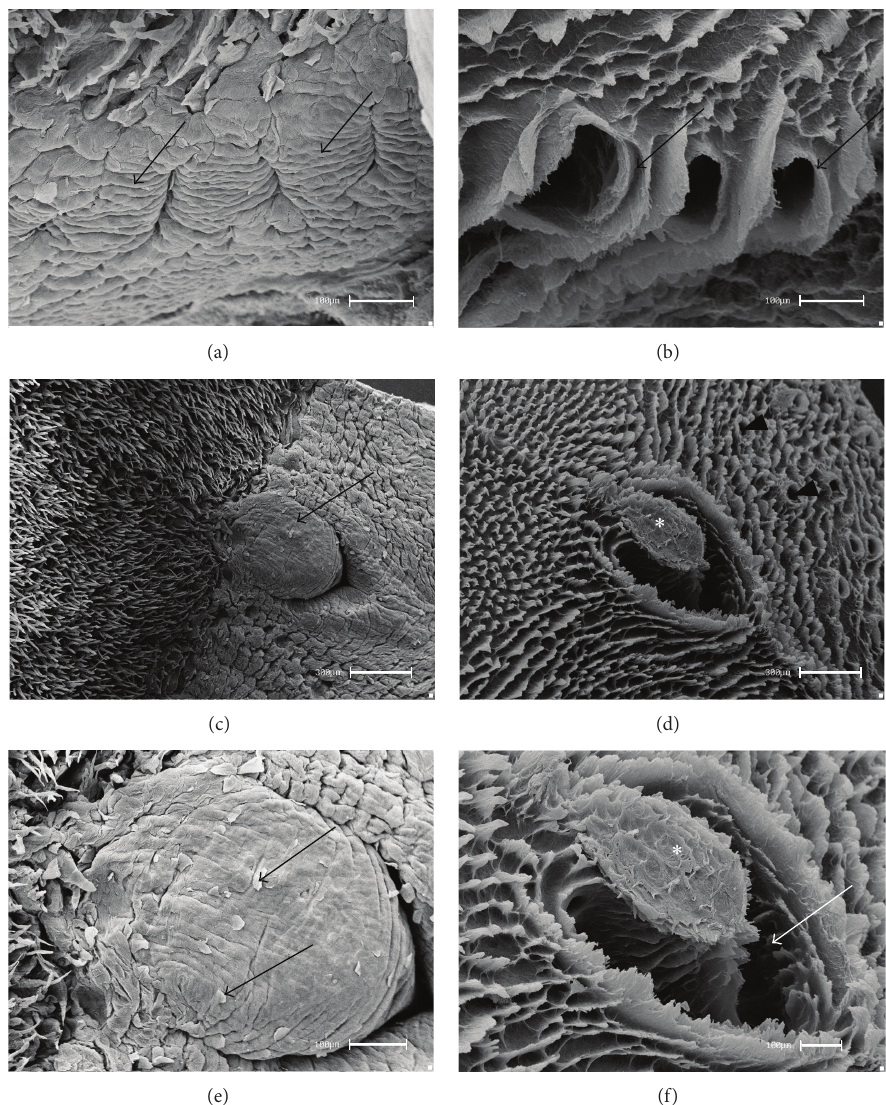
Figure2:Scanningelectronmicrographs—foliateandvallatepapillaeofrats.(a)Thefoliatepapillaeareconstitutedbyepithelialfolds(arrows) and separated by parallel grooves. (b) After the removal of the epithelial tissue, the CTCs of the foliate papillae showed wide grooves limited by laminar projections (arrows). (c) The vallate papilla (arrow) is situated in the caudal region and (d) after the removal of the epithelium the general aspects of the CTCs ( ∗ ), delimited by CTCs of the filiform papillae and salivary glands ducts (arrowheads), were observed. (e) At higher magnification, squamous epithelium (arrows) in the surface was noted. (f) At higher magnification the constitution of the CTC by a thick bundle ( ∗ ) margined by a wide groove (arrow) was revealed. Bars: 100 𝜇 m (a, b, e, f) and 300 𝜇 m (c,